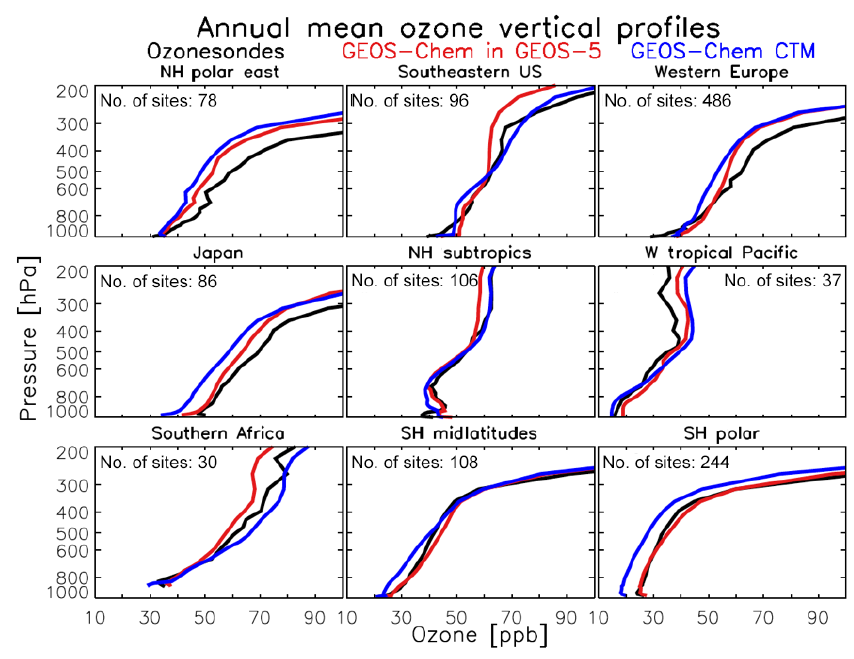
Figure 5. Annual mean ozonesonde profiles in July 2013–June 2014 for representative global regions (Tilmes et al., 2012). Results from the GEOS-5 Nature Run with GEOS-Chem chemistry (red) are compared to observations (black) and to the GEOS-Chem CTM (blue; 2 ◦ × 2 . 5 ◦ version in Hu et al., 2017). The models are sampled at the ozonesonde launch times and locations.